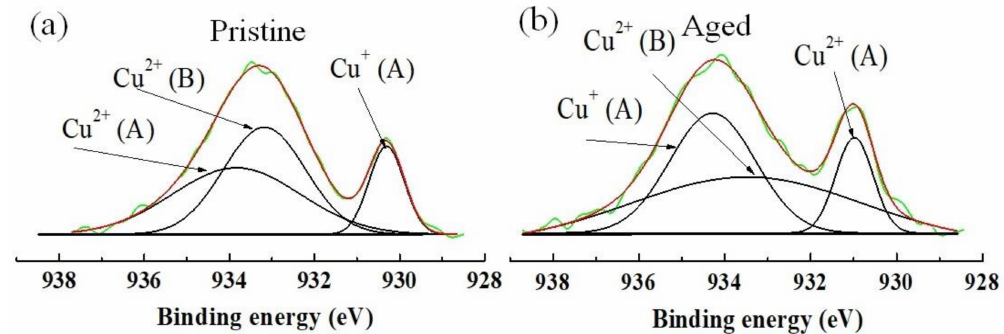
Figure 8. XPS spectra in the Cu2p 3/2 core level of S1 ceramic examined before ( a ) and after ( b ) aging at 150 ◦ C in air for 500